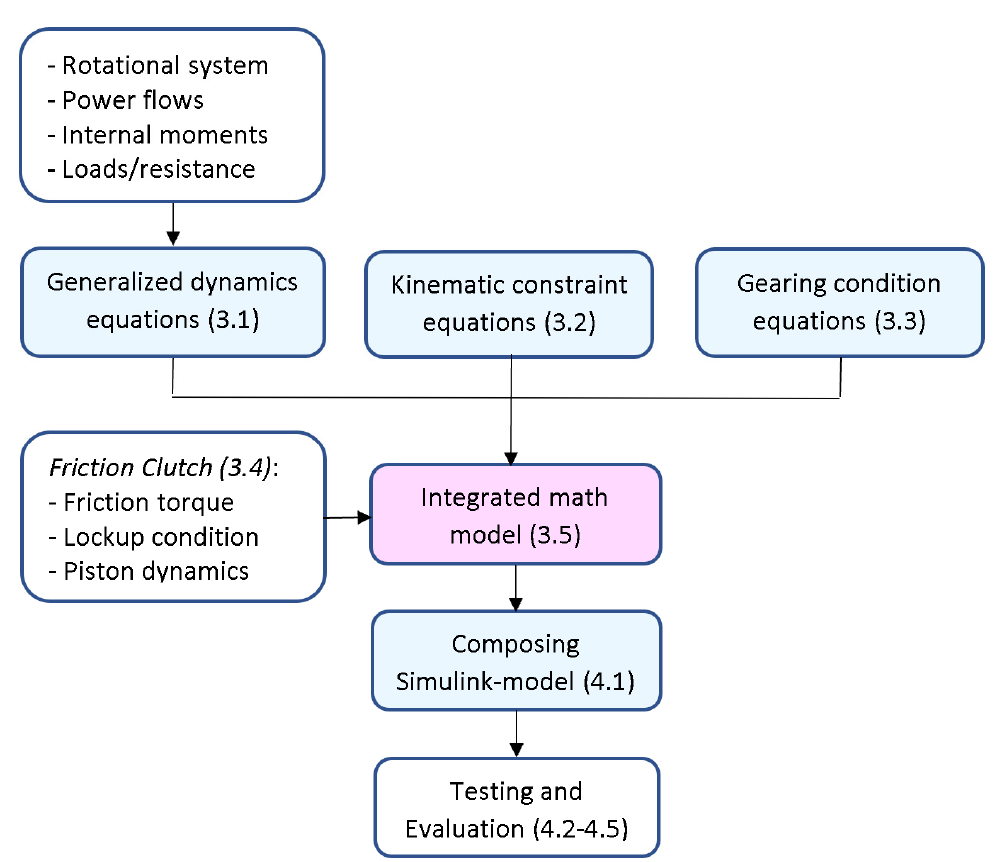
Figure 4. Process of integrated mathematical model.